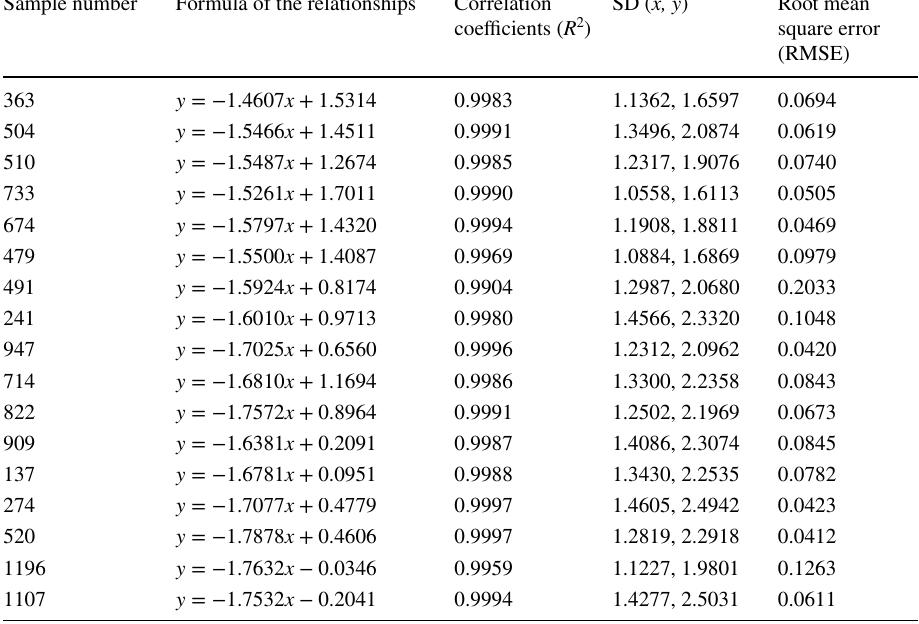
Sample number Formula of the relationships Correlation